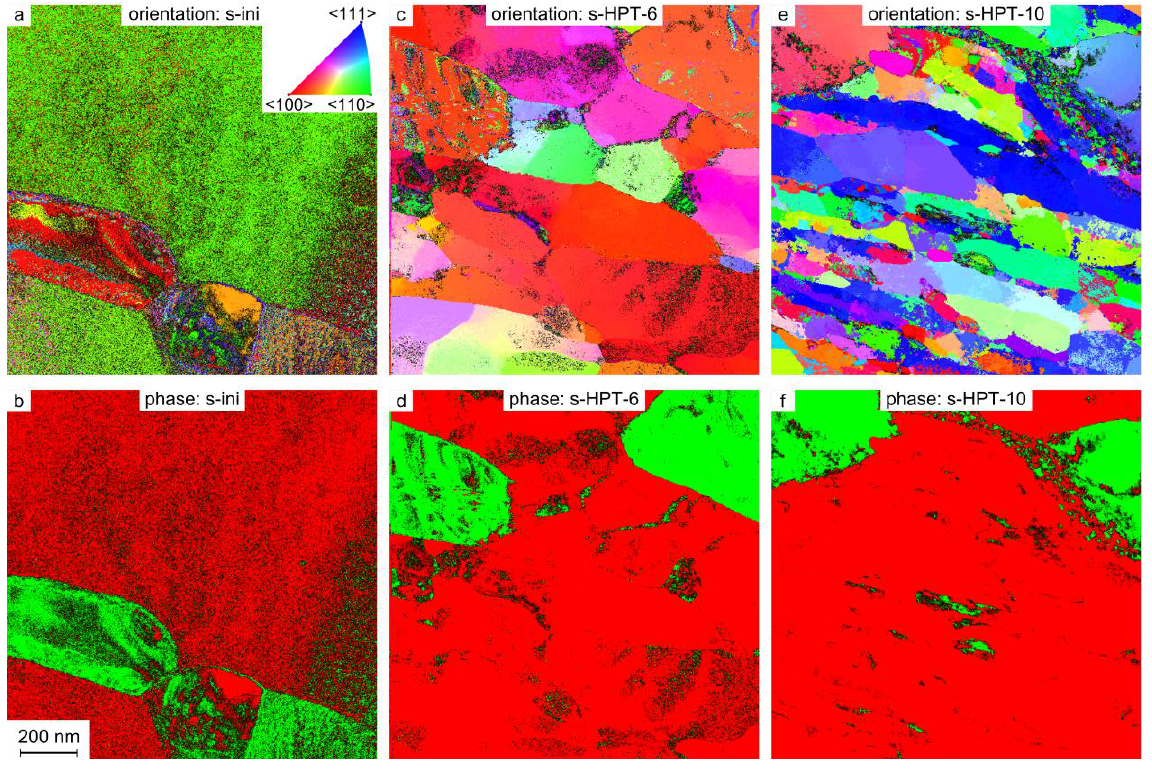
Figure 3. Orientation ( a , c , e ) and phase ( b , d , f ) maps (ACOM-TEM) overlaid with the reliability of the spheroidized microstructures ( a , b ), after 6 ( c , d ) and 10 HPT rotations ( e , f ) all prior to the fatigue tests. The color code of the orientation maps is given in ( a ). The projection direction is normal to the paper plane. The Fe phase is given in red and green represents the carbide phase. The reliability is given in black for both types of